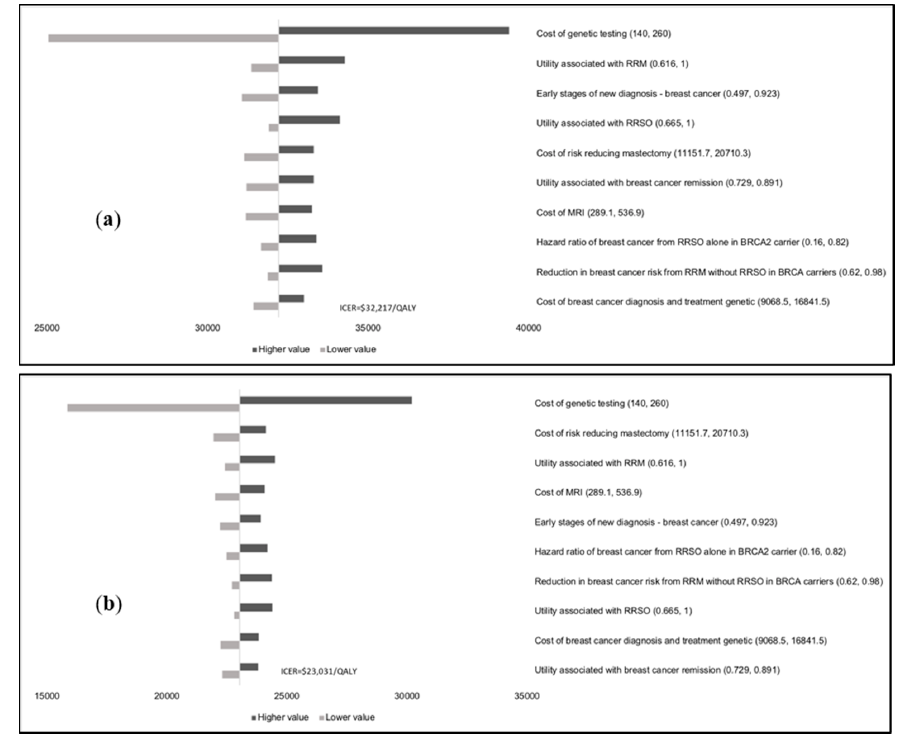
Figure A6. Tornado Diagram in India ( a ) from the healthcare payer perspective. ( b ) from the societal perspective.